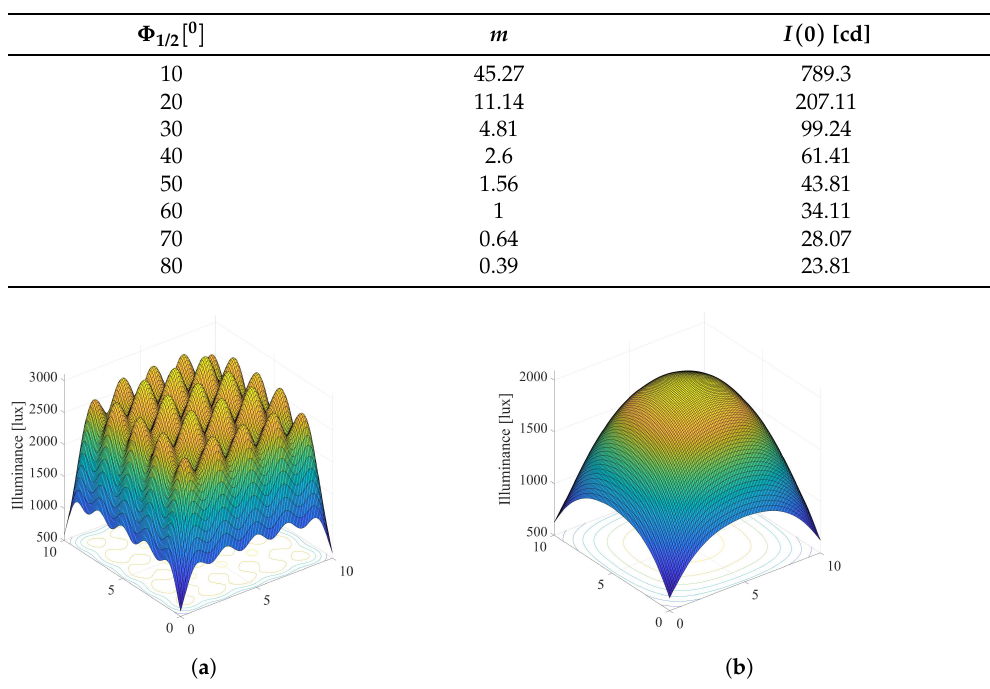
Table 1. Values of m and I ( 0 ) based on semi-angle at the half-illuminance, Φ = 107.16 lm.